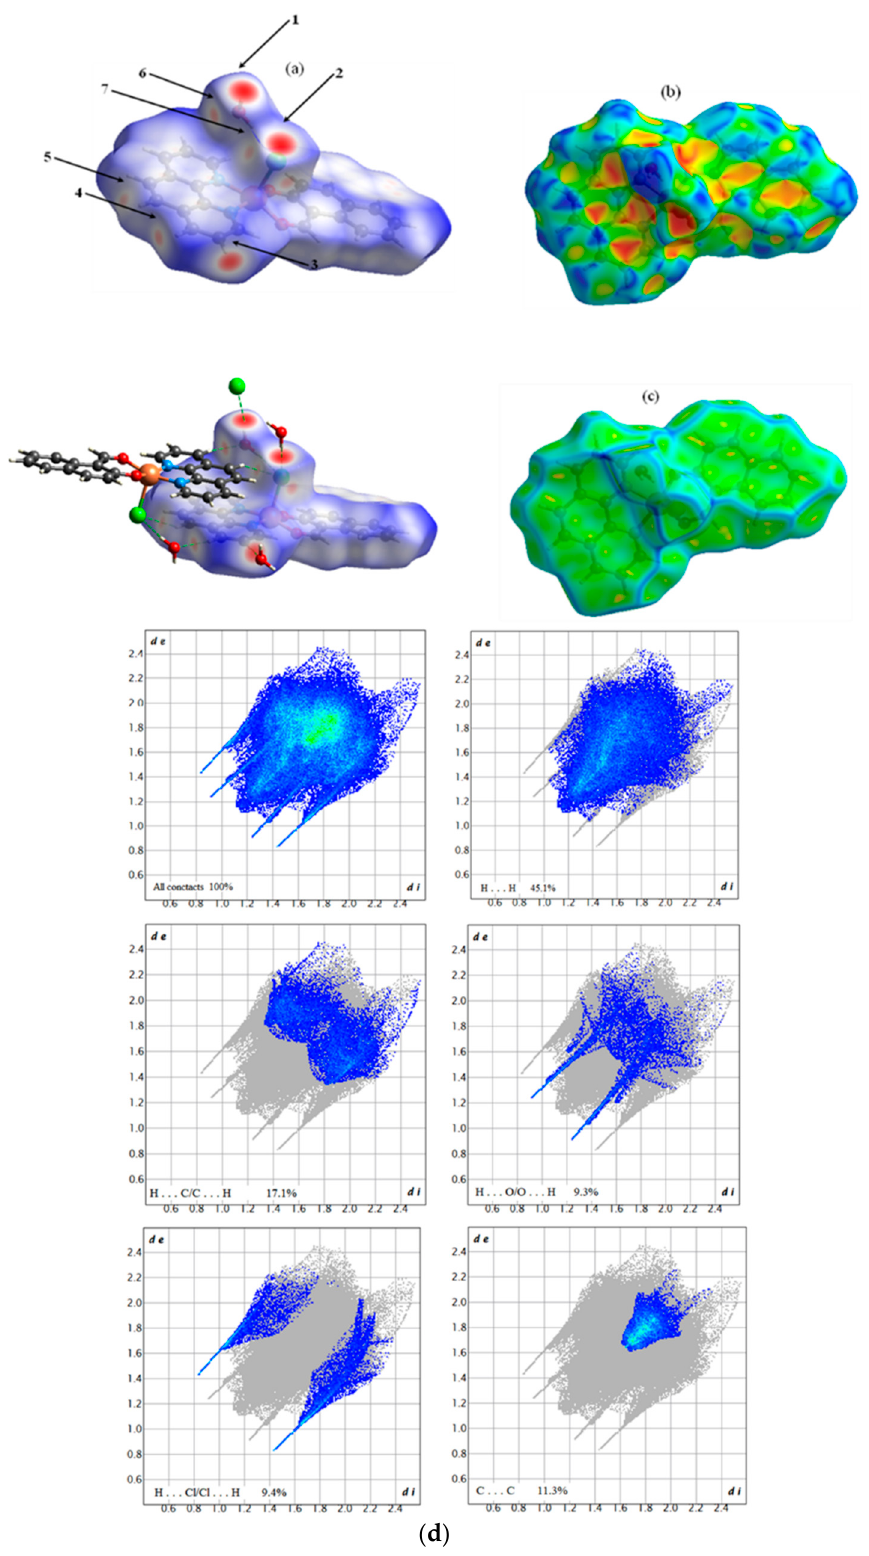
Figure 7. A view of the Hirshfeld surface for (II), which is mapped over ( a ) d norm in the range of − 0.4175 to +1.3253 arbitrary units. ( b ) Shape–index, ( c ) curvedness, and ( d ) 2-D fingerprint plots for the C-2 complex, which reveal the contributions of all